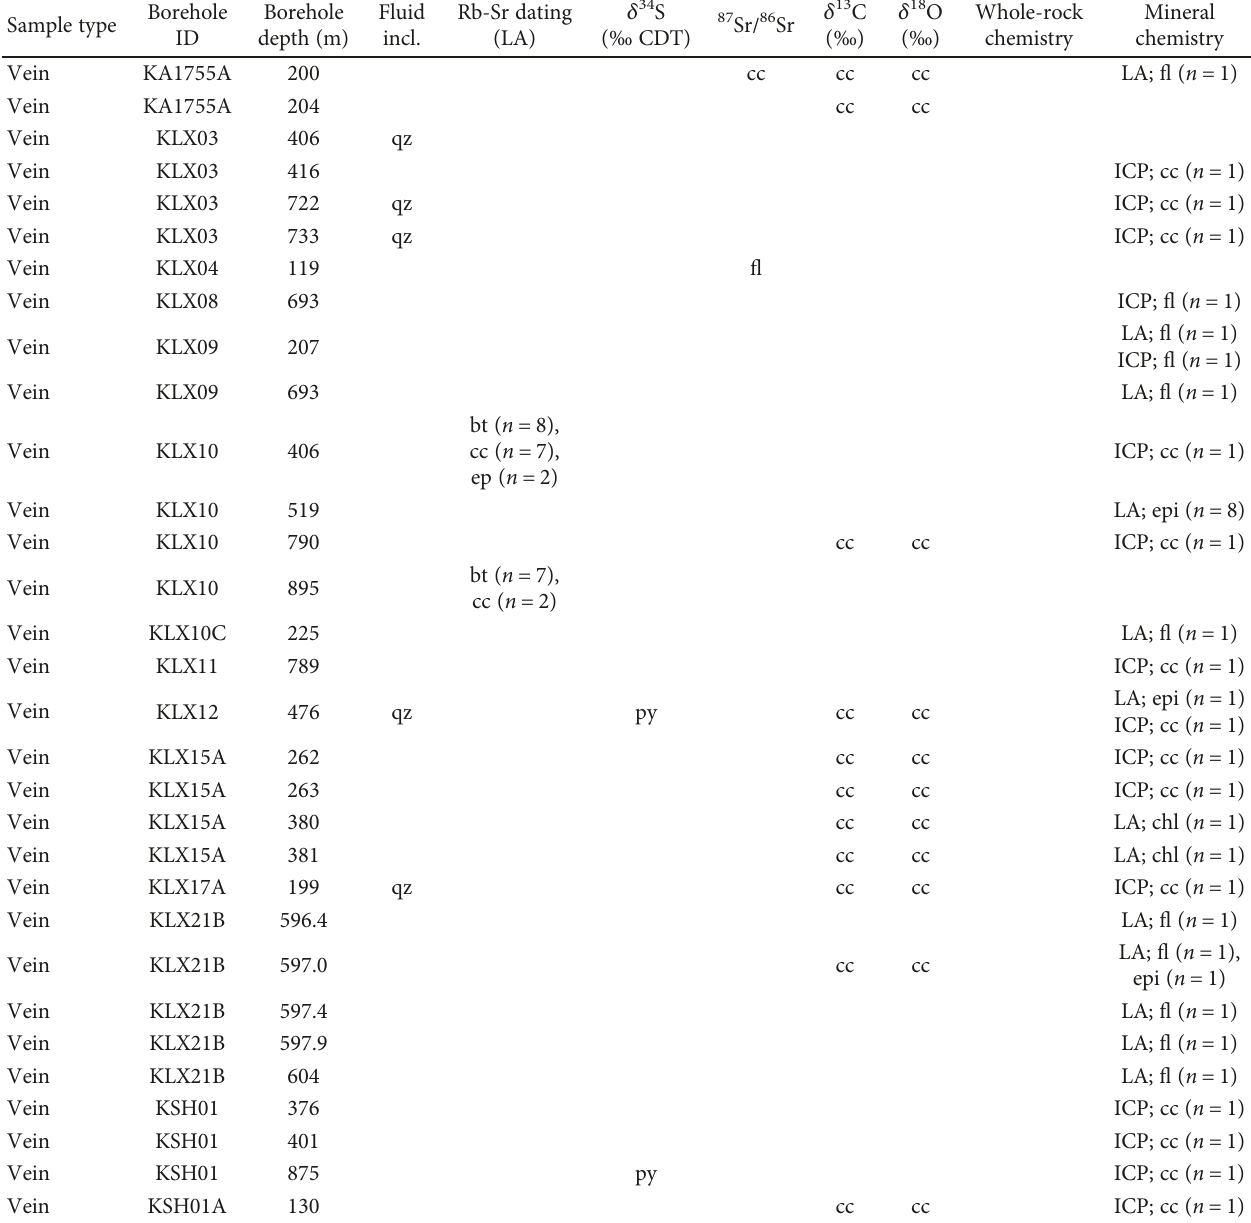
Table 1: Summary of vein samples and analytical techniques applied on